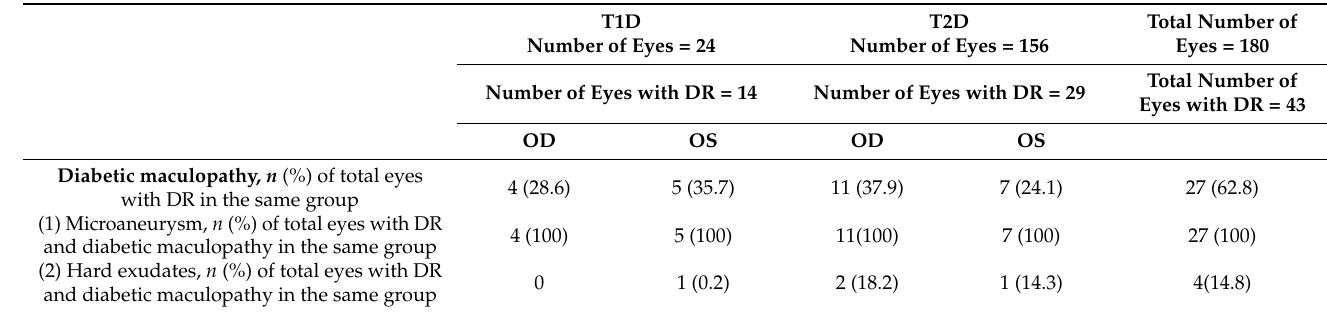
Total Number of Eyes with DR = 43